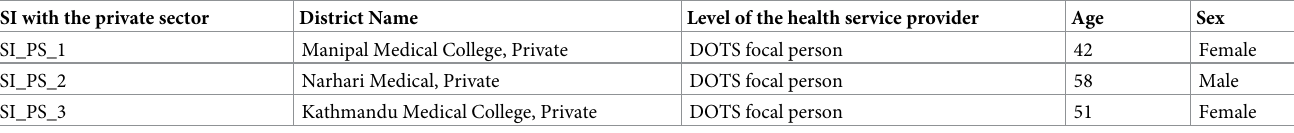
Table 3. Semi Structure Interview with private sector health service